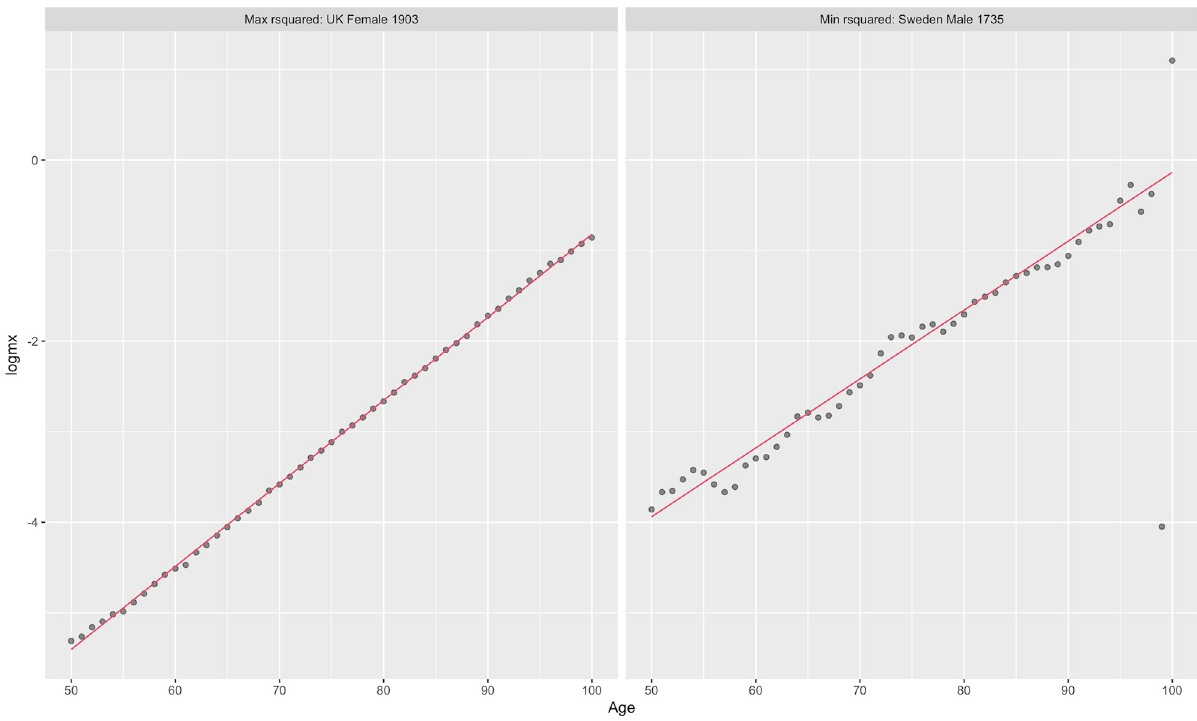
Fig 2. Extinct cohorts with highest (left) and lowest (right) R-squared in our dataset.